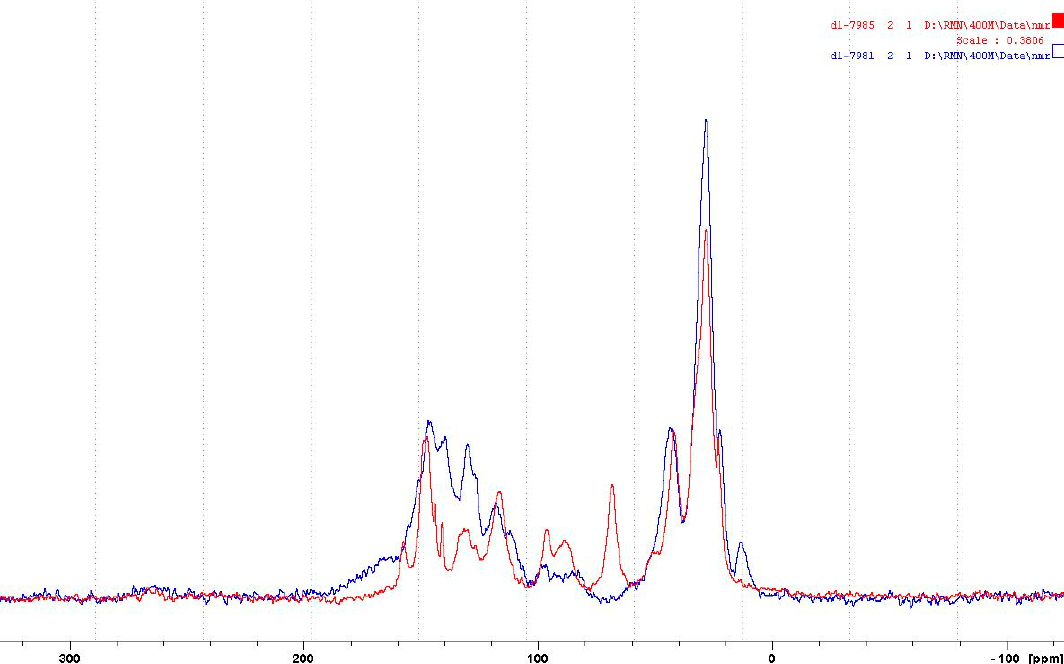
Figure 20. Superposition for comparison of the CP-MAS 13 C NMR spectra of the reactions of catechin with hexamethylene diamine at 185 °C (blue curve) and at 100 °C (red curve), both pTSA-catalysed.